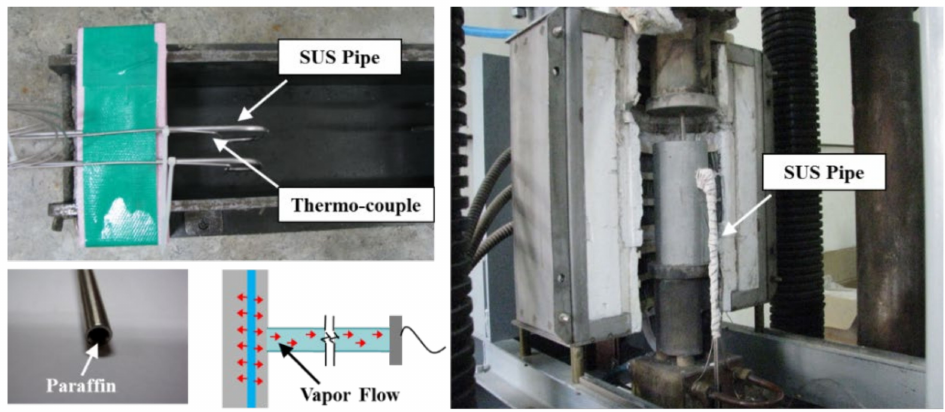
Figure 7. Test method for determining the water vapor